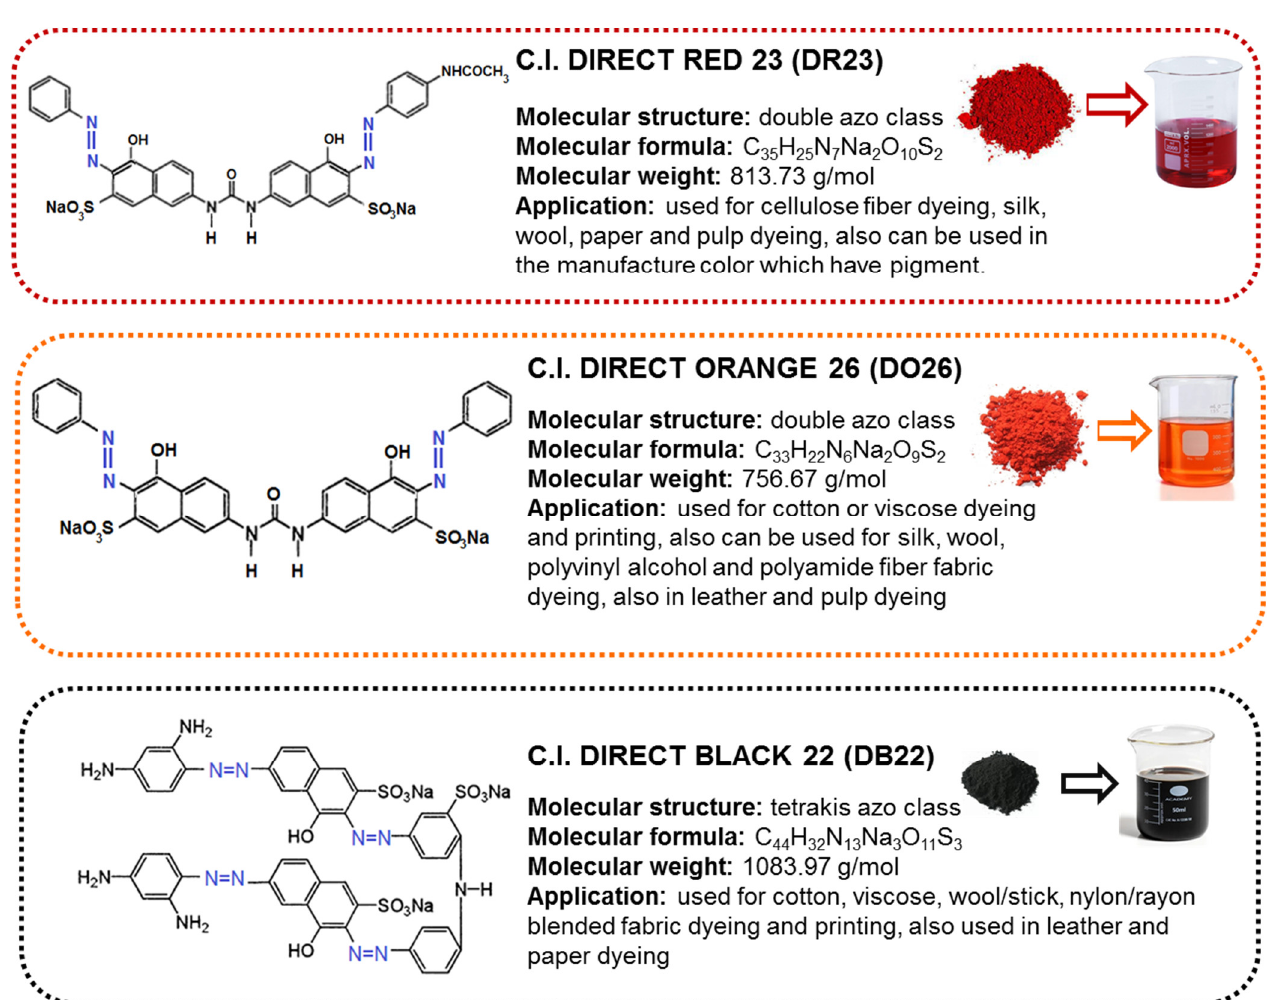
Figure 1. Examples of popular direct dyes–structures and properties.